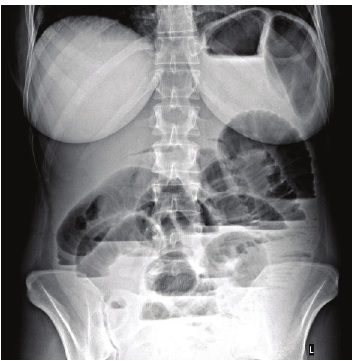
Figure 1: Erect abdominal X-ray on admission with distended bowels showing fluid